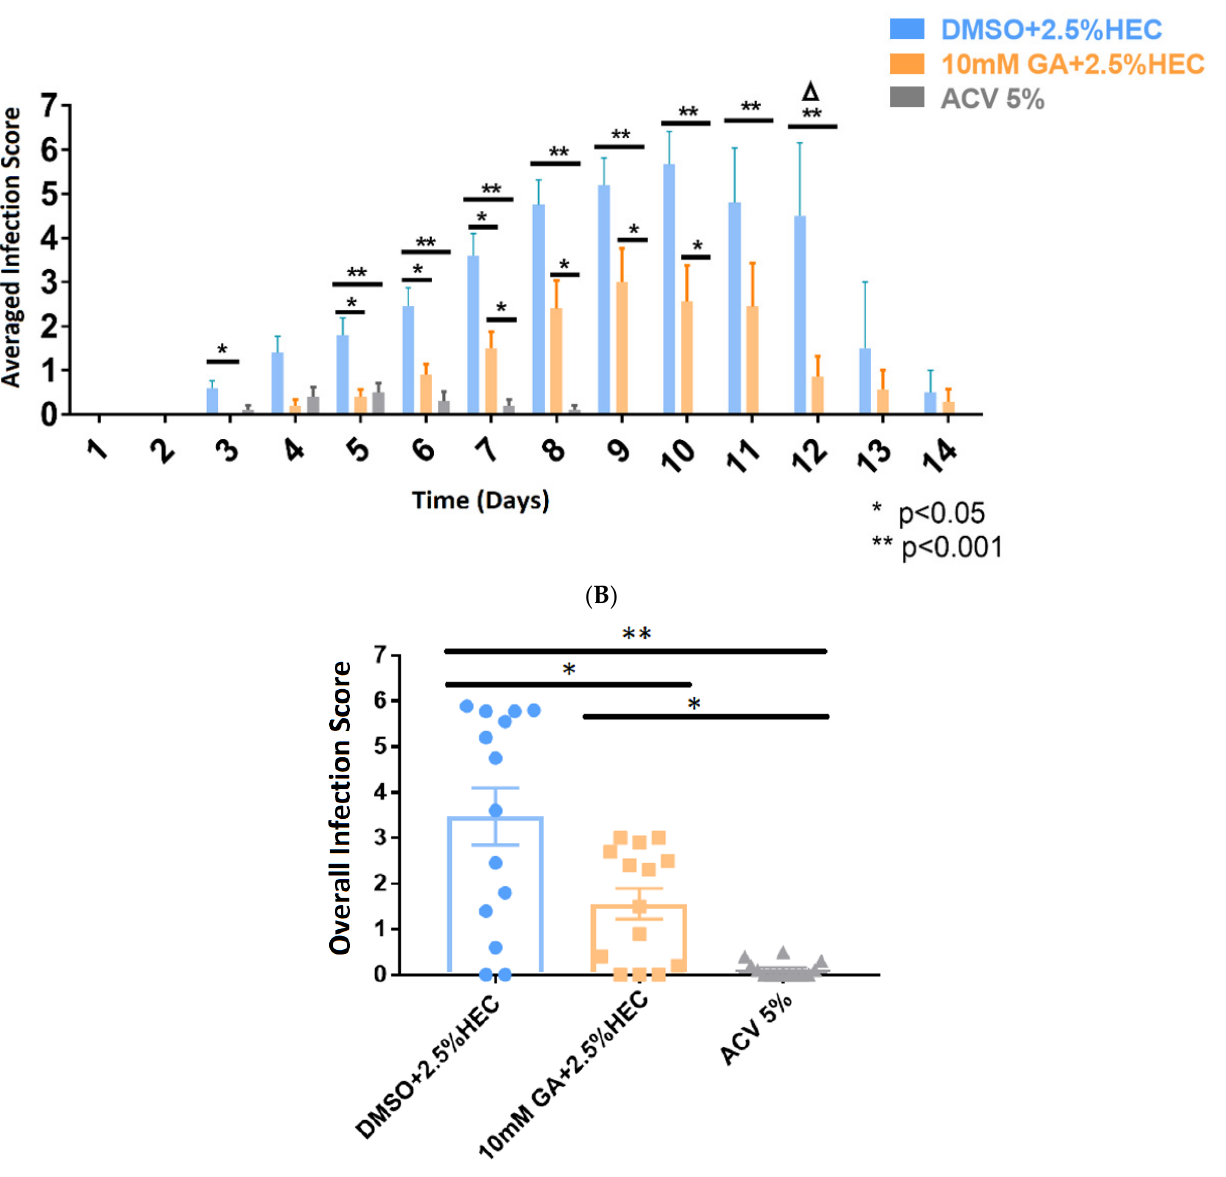
Figure 2. GFP-HSV-1 average zosteriform infection scores of BALB/cJ mice (N = 10/treatment), following the application of DMSO in 2.5% HydroxyEthyl Cellulose (HEC) gel, 10 mM GA in HEC gel, and ACV USP 5%. ( A ) Age-matched BALB/cJ mice were inoculated with 6 × 10 4 PFU of GFP-HSV-1, given respective treatments, and monitored for survival for 14 days. ( B ) Averaged infection scores of surviving animals in each treatment group across 14 days. ( C ) Combined and averaged infection score of all animals per day for 14 days. GA-treated animals demonstrated a significant reduction in the appearance of vesicles and erosions compared to vehicle-treated control animals. ( B ) Student independent t -tests (2-tailed) and ( C ) One-way ANOVA [F(2, 39) = 12.31]; * p < 0.05, ** p < 0.001. ∆ indicates that 8 out of 10 animals in the DMSO-treated group died by day 12 p.i. All error bars represent SEM.